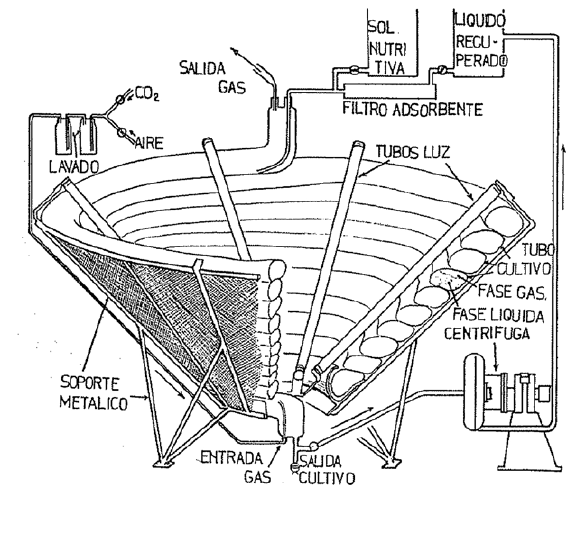
Fig. 13. – The “Helicotrefon”, one of the physical models used by Margalef in the study of plankton succession. The system consisted of a transparent helicoidal plastic tube supported by an inverted conical frame. Nutrients and inoculum were introduced in the upper part. The continuous nutrient flow was regulated according to the duplication rate of the species so that the maximum algal concen- tration occurred in the lower end, where algae were separated and concentrated with a continuous centrifuge. The liquid, once the con- sumed nutrients had been amended, was incorporated again at the upper end. It could be an interesting prototype for mass production of microalgae. (Margalef 1956a).